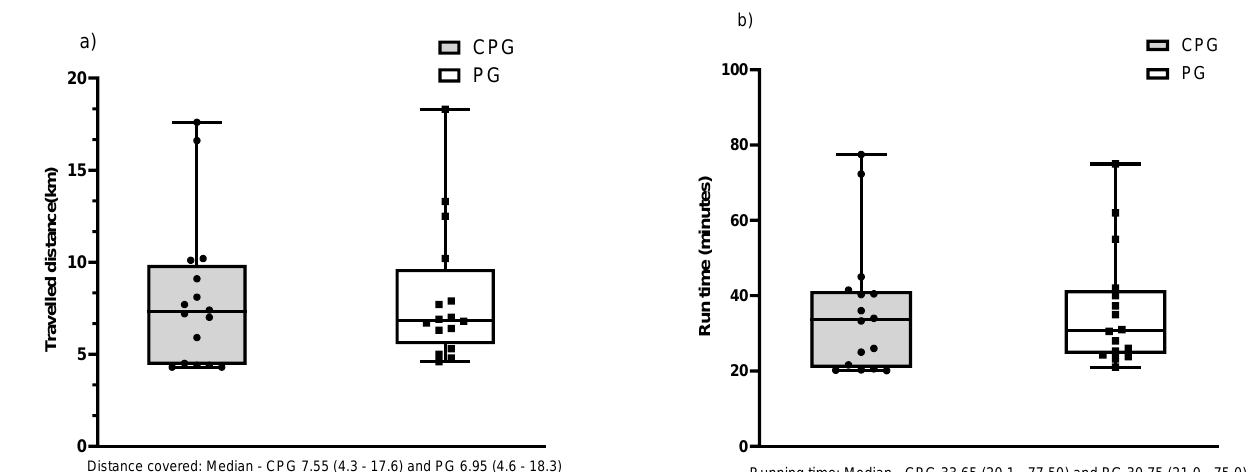
Figure 2. Graphs representing the comparison between the CPG and GP groups in the following variables: ( a ) distance and ( b ) running time. Values show in median and IQR.